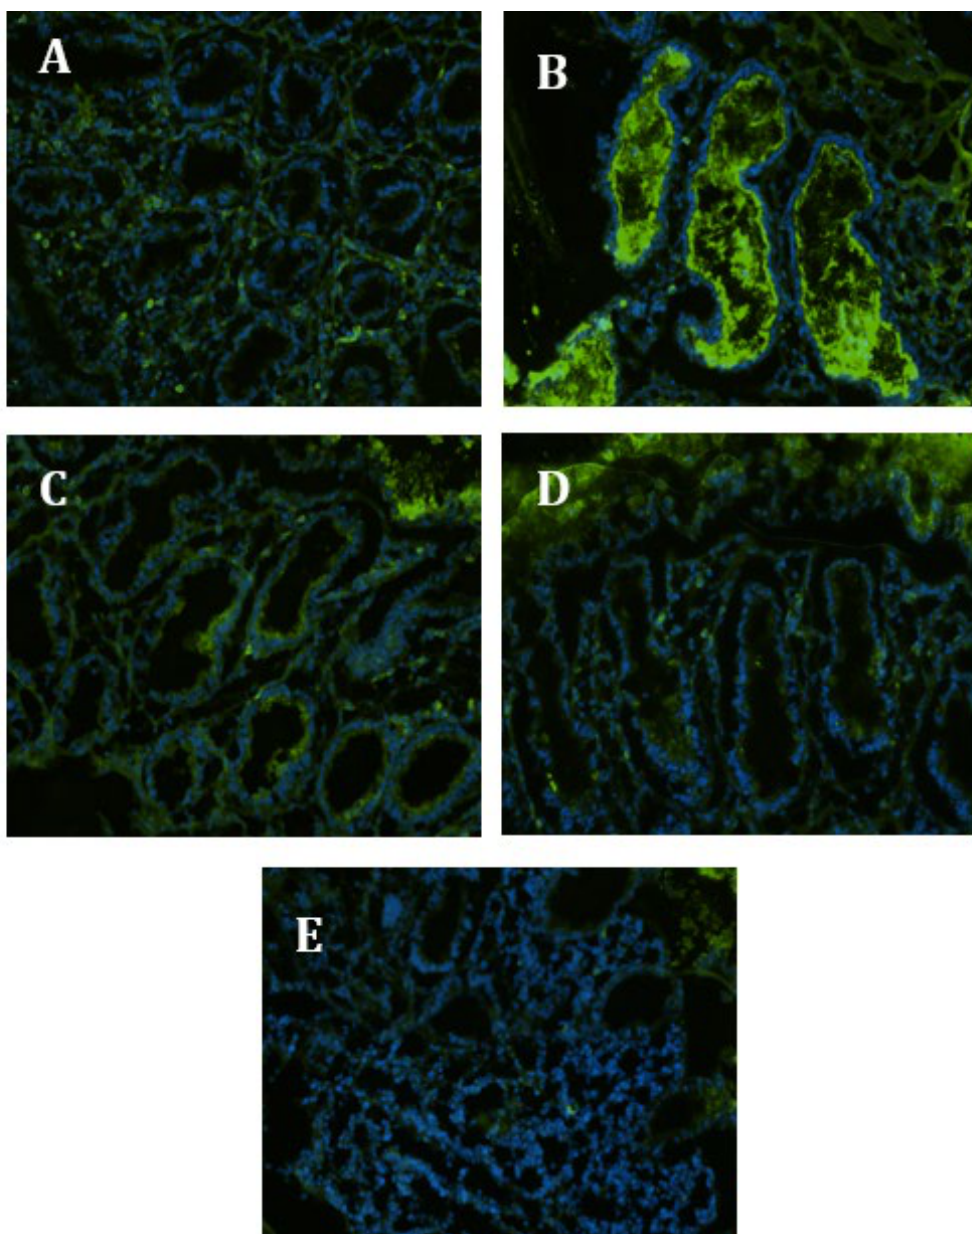
Figure 3. GAAE pre- treatment effect on NF- κ B expression in situ in normal controls challenged Figure 3. GAAE pre-treatment effect on NF- κ B expression in situ in normal controls challenged with EC-LPS . ( A ) No treated biopsy; ( B ) biopsy challenged with 1 µg/mL EC - LPS for 1 8 h ; ( C ) bi- with EC-LPS . ( A ) No treated biopsy; ( B ) biopsy challenged with 1 µ g/mL EC-LPS for 18 h; ( C ) biopsy opsy pretreated 3 h with 50 µg/mL GAAE , then challenged with 1 µg/mL EC - LPS for 1 8 h ; ( D ) pretreated 3 h with 50 µ g/mL GAAE, then challenged with 1 µ g/mL EC-LPS for 18 h; ( D ) biopsy biopsy pretreated 3 h with 100 µg/mL GAAE , then challenged with 1 µg/mL EC - LPS for 1 8 h ; ( E ) biopsy pretreated only with 100 µg/mL GAAE for 21 h . pretreated 3 h with 100 µ g/mL GAAE, then challenged with 1 µ g/mL EC-LPS for 18 h; ( E ) biopsy pretreated only with 100 µ g/mL GAAE for 21